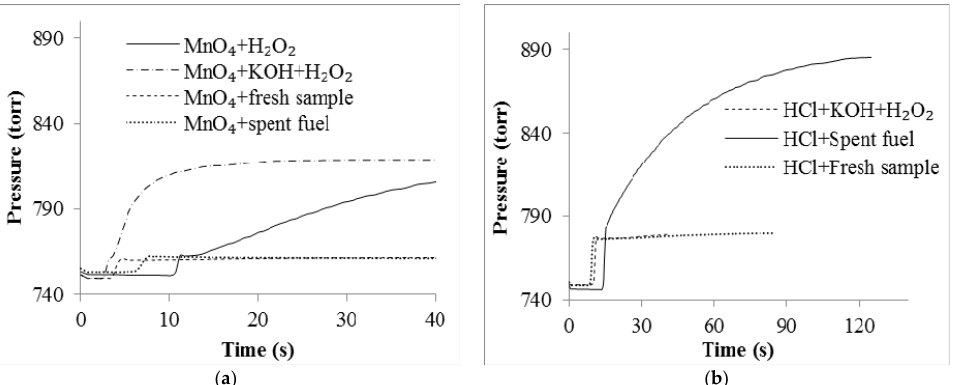
Figure A3. ( a ) Pressure assay with suspension of MnO 2 . Control 1 is suspension of MnO 2 with 100 µ L H 2 O 2 . Control 2 is suspension of MnO 2 with 100 µ L H 2 O 2 in 8M KOH; ( b ) Acidify pressure assay curve where the control is 1M HCl 8M KOH + 100 µ L H 2 O 2 . The initial rate in terms of pressure and time was determined through the slope of the trend